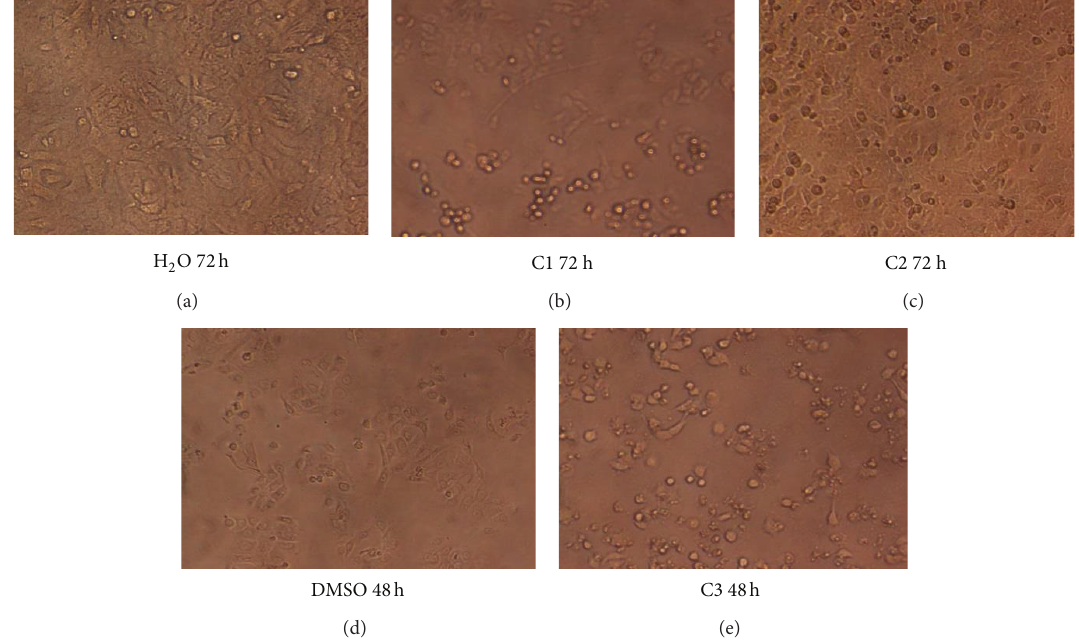
Figure 6: Microscope images (20x) of A549 cells with controls (H 2 O and DMSO) and IC 50 values of metal complexes for 48 and 72 hours. (a) image of A549 cells at 72 h with distilled water as a control; (b) and (c) images of the cells at 72 h with IC 50 values of C1 and C2 complexes, respectively; (d) image of the cells at 48h, incubated with DMSO as a control of C3 complex; (e) image of the cells at 48 h, incubated with IC 50 value of